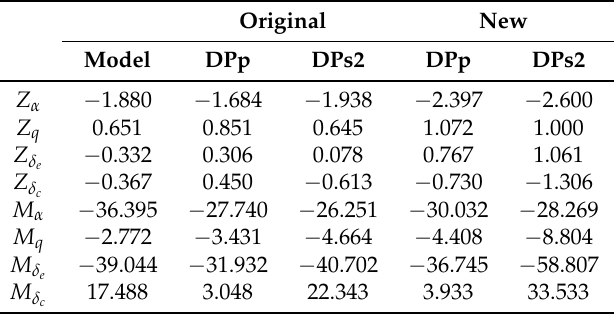
Table 5. Comparison of the estimates for the classic double pulse (DP) input signal run separately and in parallel. The model (17) is given as a